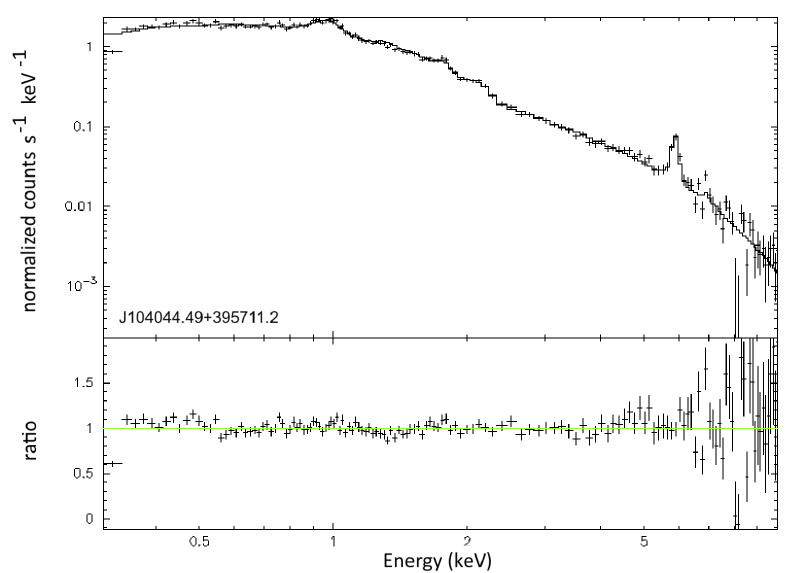
Figure 5. An example of X-ray spectral fitting of our sample in the range of 0.3–10 keV from XMM- Newton observations with the corresponding optical spectrum presented in Figure